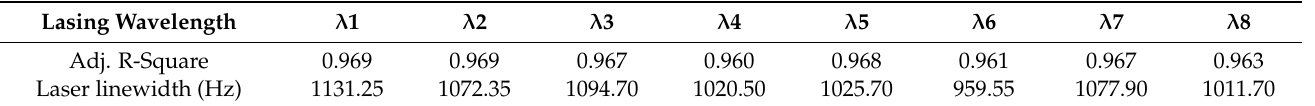
Figure 7. Linewidth measurements of the single-wavelength operations using DSHMS at ( a ) λ 2 and ( b ) λ 7 lasing, with the averaging mode for an RBW of 100 Hz. Table 2. Linewidth measurement results for all the single-wavelength lasing